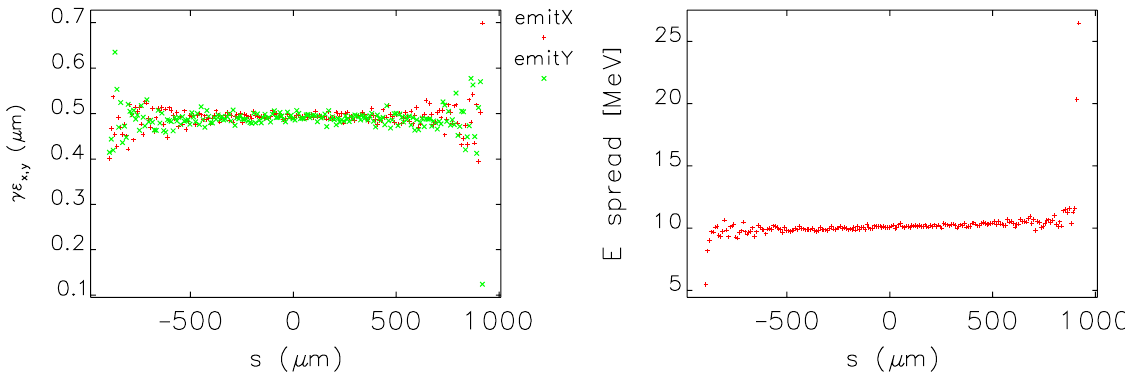
FIG. 9. Sliced normalized emittance and energy spread along the longitudinal direction in a bunch. Left: Sliced normalized emittance. Right: Sliced energy